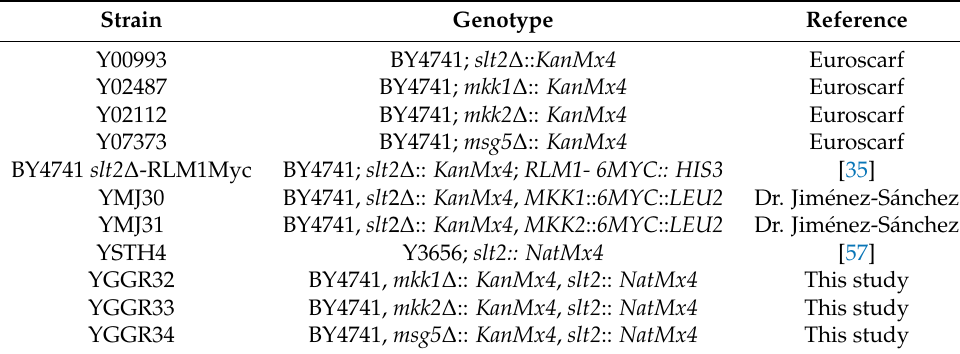
Table 2. Yeast strains used in this